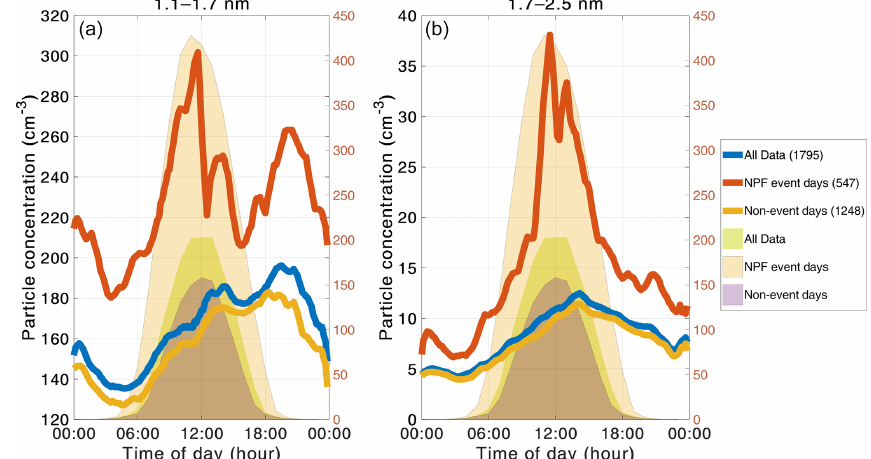
Figure 6. The median diurnal cycles of the particle concentrations for the 1.1–1.7nm (a) and 1.7–2.5nm (b) size ranges. The blue, red, and yellow lines show the concentrations for the entire data set, new particle formation events, and non-event days, respectively. The light green, light red, and lilac shading are the diurnal cycles of global radiation for all data, NPF event days, and non-event days, respectively (right y axis). The number of days included in the median day is presented by the number in parentheses in the